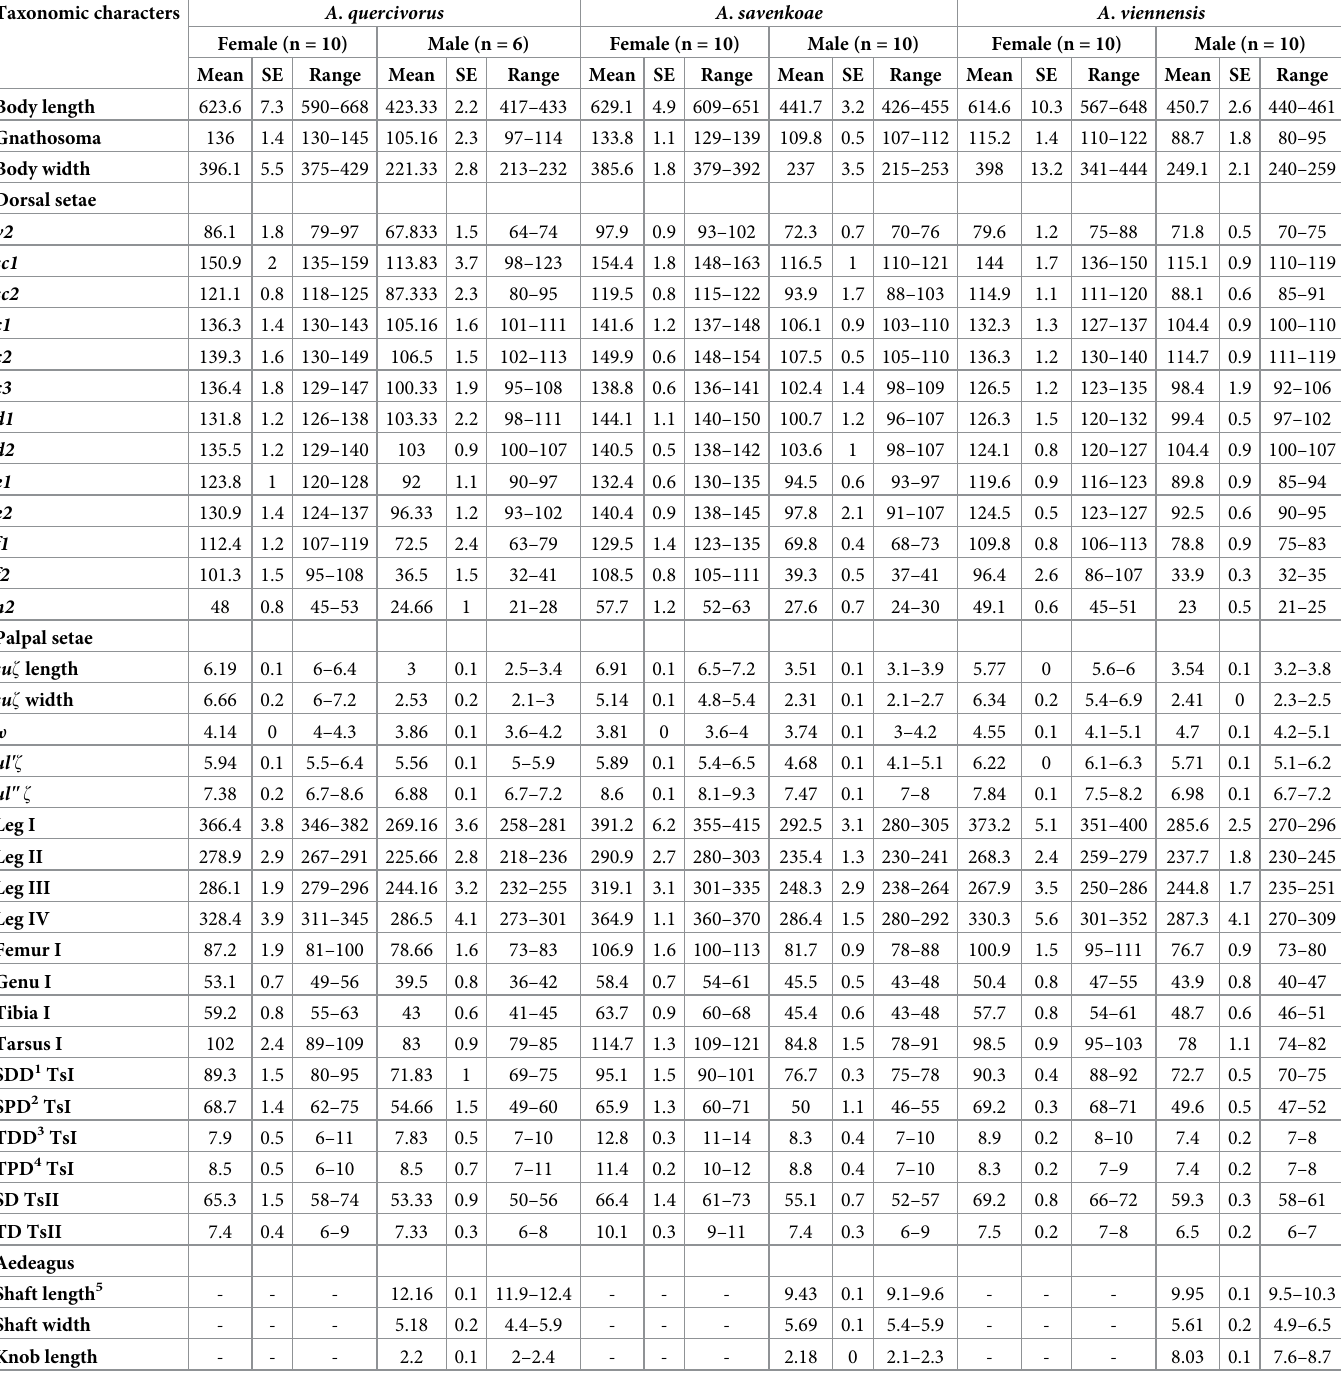
Table 2. Mean, standard error (SE) and range of taxonomic characters measured for females and males of Amphitetranychus quercivorus , A . savenkoae and A . viennensis